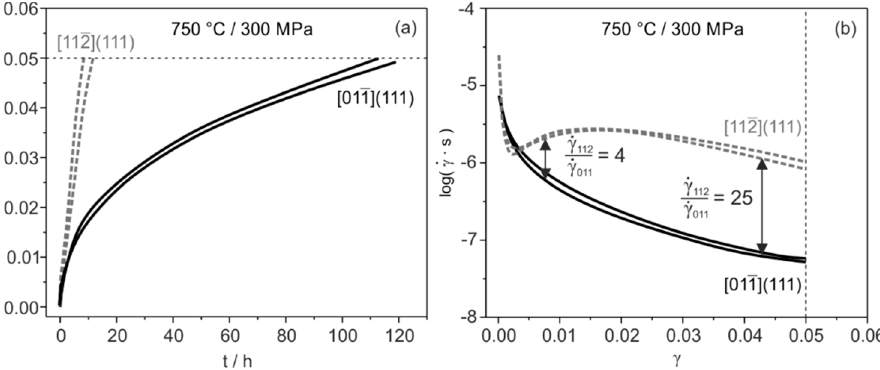
Figure 3. Direct comparison of the creep behavior of the two macroscopic shear systems [ 011 ]( 111 ) and [ 112 ]( 111 ) at 750 ◦ C and 300 MPa. ( a ) Creep curves presented as shear strain γ vs. time t. ( b ) Creep data presented as log( γ ) vs. γ .